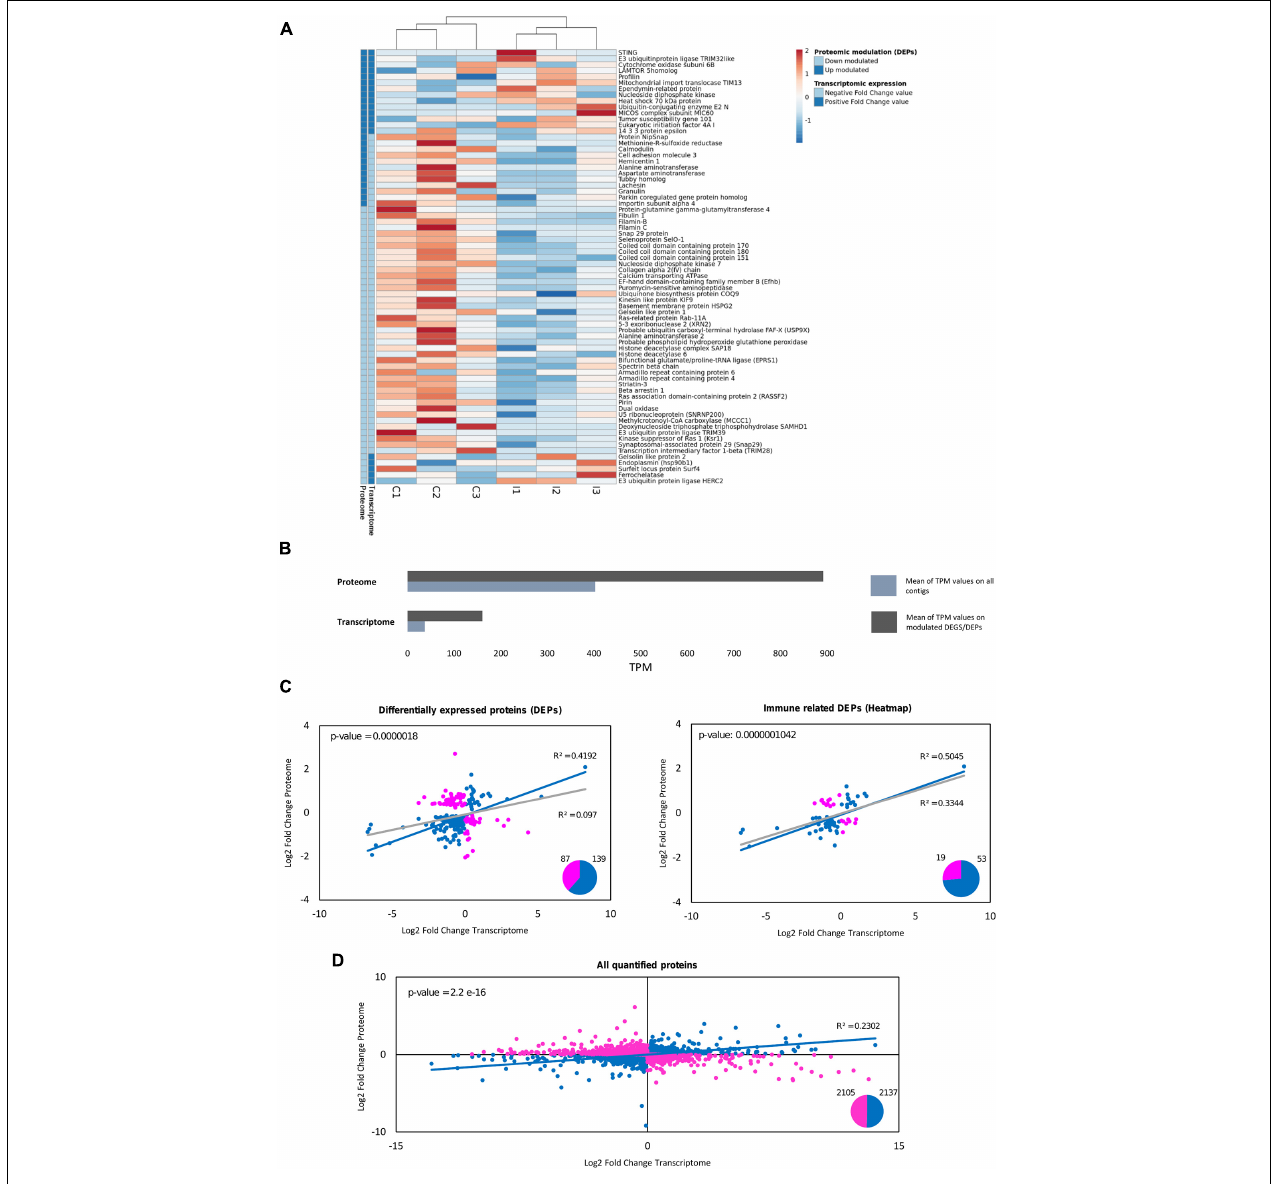
FIGURE 6 | Comparative analysis between proteomic quantification and transcriptomic expression for the differentially expressed proteins (DEPs). (A) For the immune-related DEPs, the mRNA expression of their equivalent contigs was retrieved from a previous transcriptomic study in gills against the same bath infection, which was also used as a database for proteomic identification (Saco et al., 2020). The heatmap shows the expression in TPMs (transcripts per million) for these immune DEPs in each individual sample used for the transcriptomic analysis (three biological replicates for each group: control and infected). The legend in the heatmap indicates for every protein if their fold change values (both in the proteome and in the transcriptome) are positive (dark blue) or negative (light blue). (B) Average TPM values are represented for the whole transcriptome and for the differentially expressed contigs, as well as for the equivalent contigs to the proteins quantified in the proteome and the DEPs. How the proteins detected in the proteome correspond to contigs with higher average expression than the overall transcriptome (it is more possible to identify in proteomics a term with high transcriptomic expression than one with low expression) can be seen. (C) Correlation analysis between the log 2 -fold change values of the proteomic quantification and the transcriptomic expression of the DEPs. From the total number of 226 DEPs, 87 were discordant gene-protein pairs, indicated in pink (different trend between both approaches), and 139 (61%) were concordant gene-protein pairs, indicated in blue (same expression trend between both approaches). The R-squared value when considering all the DEPs (gray line) and when considering the concordant gene-protein pairs (blue line) are represented, as well as the p -value of the fold change value correlation for the concordant gene-protein pairs. The same correlation analysis was performed considering only the immune-related DEPs, the same ones that were used in (A) . How the correlation increases with certain types of modulated genes (immune functions) can be seen, while it is highly decreased in other functions (cytoskeletal-related DEPs, with R 2 = 0.0641; data not shown). (D) Correlation analysis between the log 2 -fold change values of the proteomic quantification and the transcriptomic expression for all the quantified proteins in the proteome. The regression analysis considering the whole proteome was not significant. From the total number of 4,242 quantified proteins, 2,105 were discordant gene-protein pairs (pink), while 2,137 were concordant gene-protein pairs (blue). All the concordant gene-protein pairs (blue dots) were used for the represented regression (blue line), and the R 2 and p -value are indicated for this analysis with concordant terms.